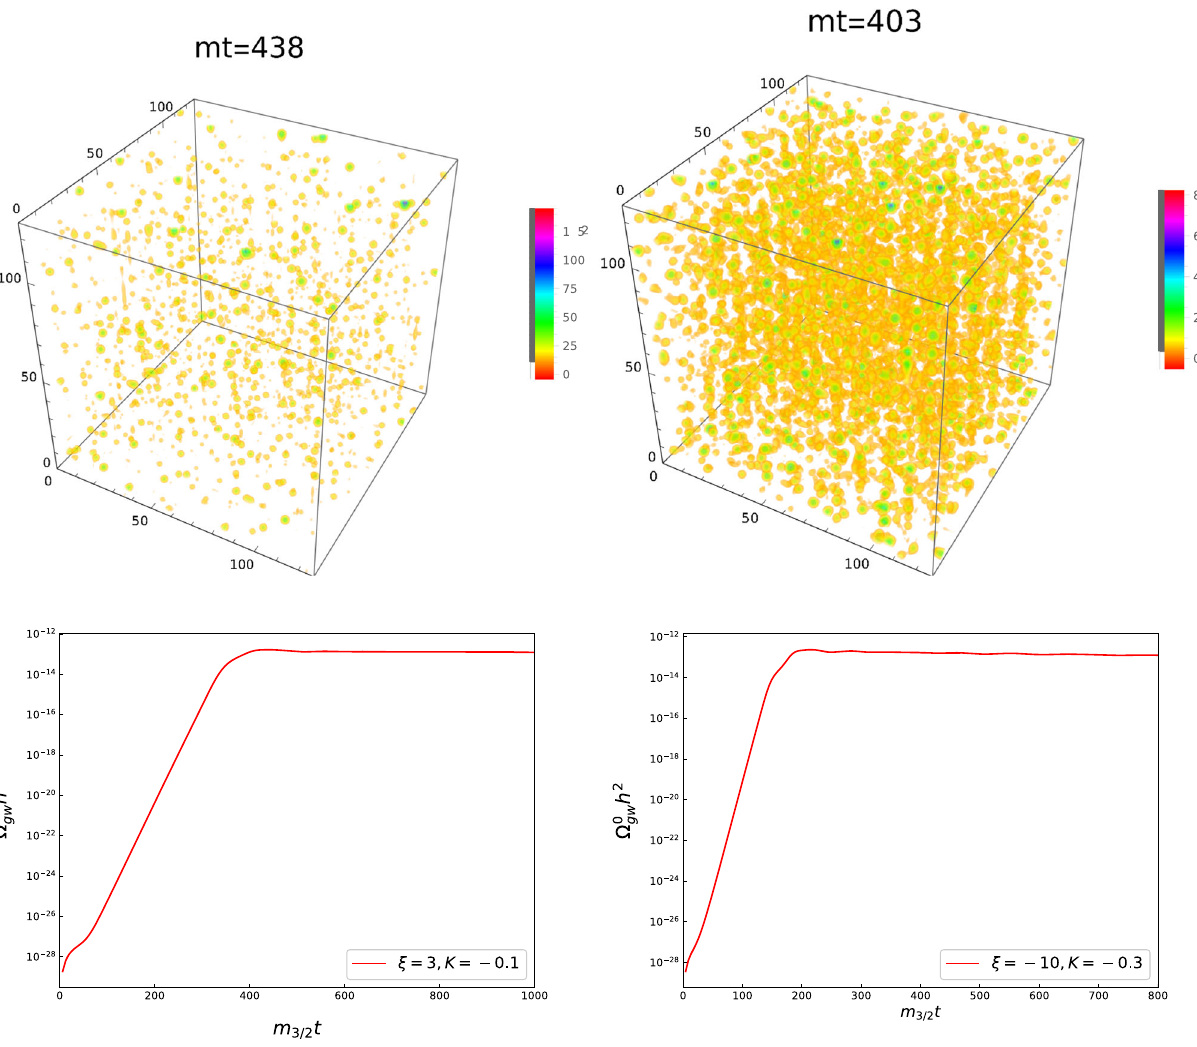
Fig. 3 Benchmark points with K = − 0 . 1 ,ξ = 3 (left panels) and K = − 0 . 3 ,ξ = − 10 (right panels). The forms of the final-stage massive Q-balls for both cases are shown in the upper panels. The evolution of the GW density parameter (cid:12) 0 g w h 2 with respect to m 3 / 2 t